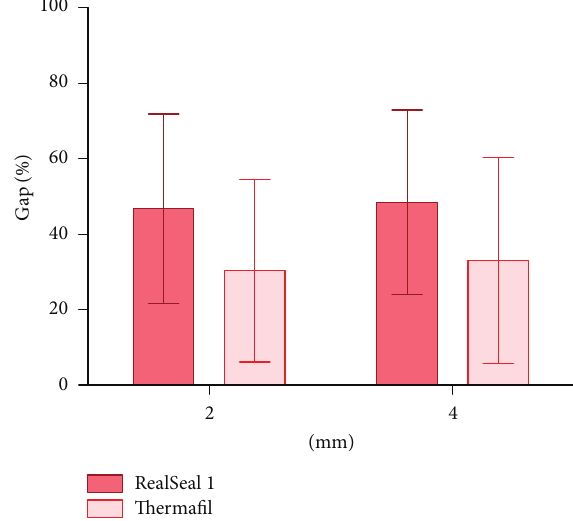
Figure 3: Showing the mean percentage of gap observed in RealSeal 1 and Thermafil at 2mm and 4mm sections away from the root